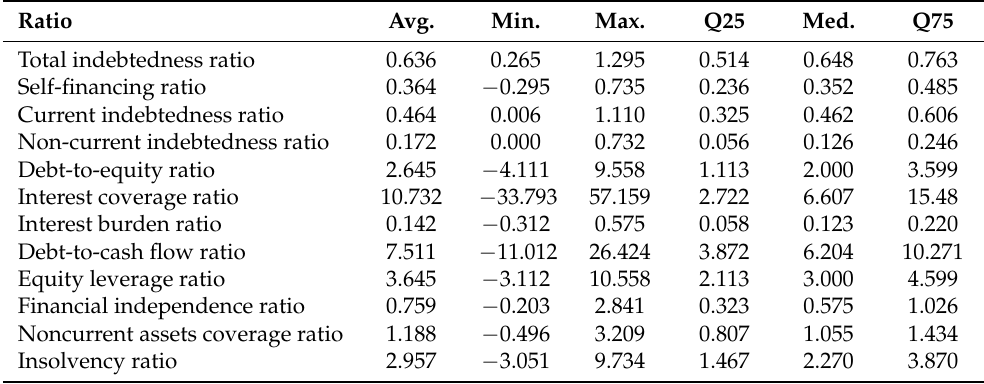
Table 3. Descriptive statistics of indebtedness